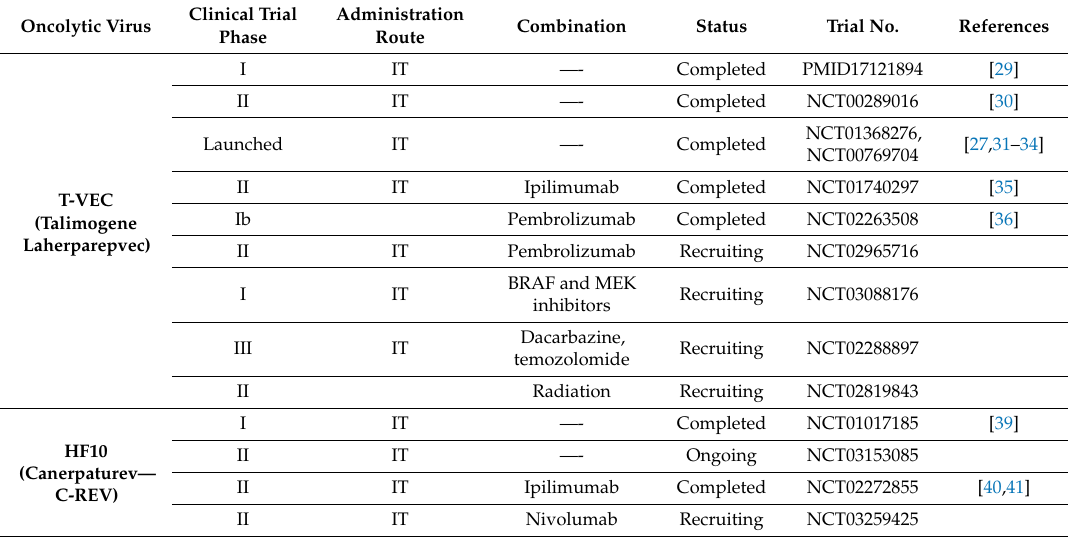
Table 2. The clinical trials of oncolytic viruses in patients with melanoma. Clinical Trial Administration Oncolytic Virus Combination Status Trial Phase Route